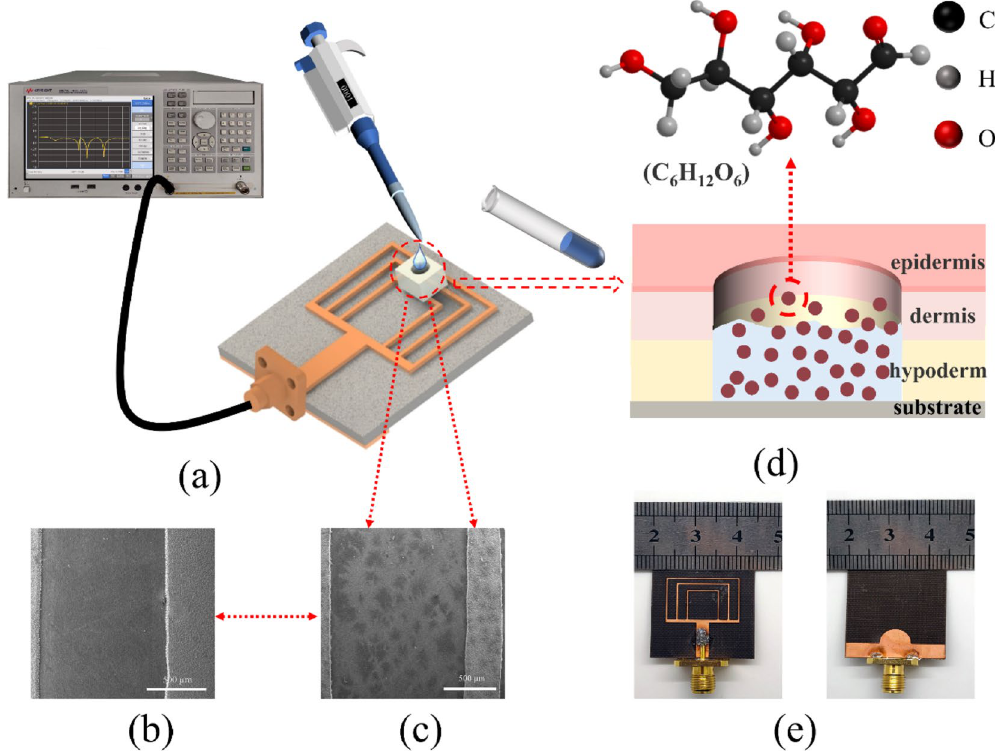
Figure 9. ( a ) The measurement setup for the experiment, ( b ) SEM image of the bare biosensor, ( c ) SEM image after adding the sample for measurement, ( d ) schematic diagram of the glucose biosensor, ( e ) optical photograph of the proposed biosensor (front view and back